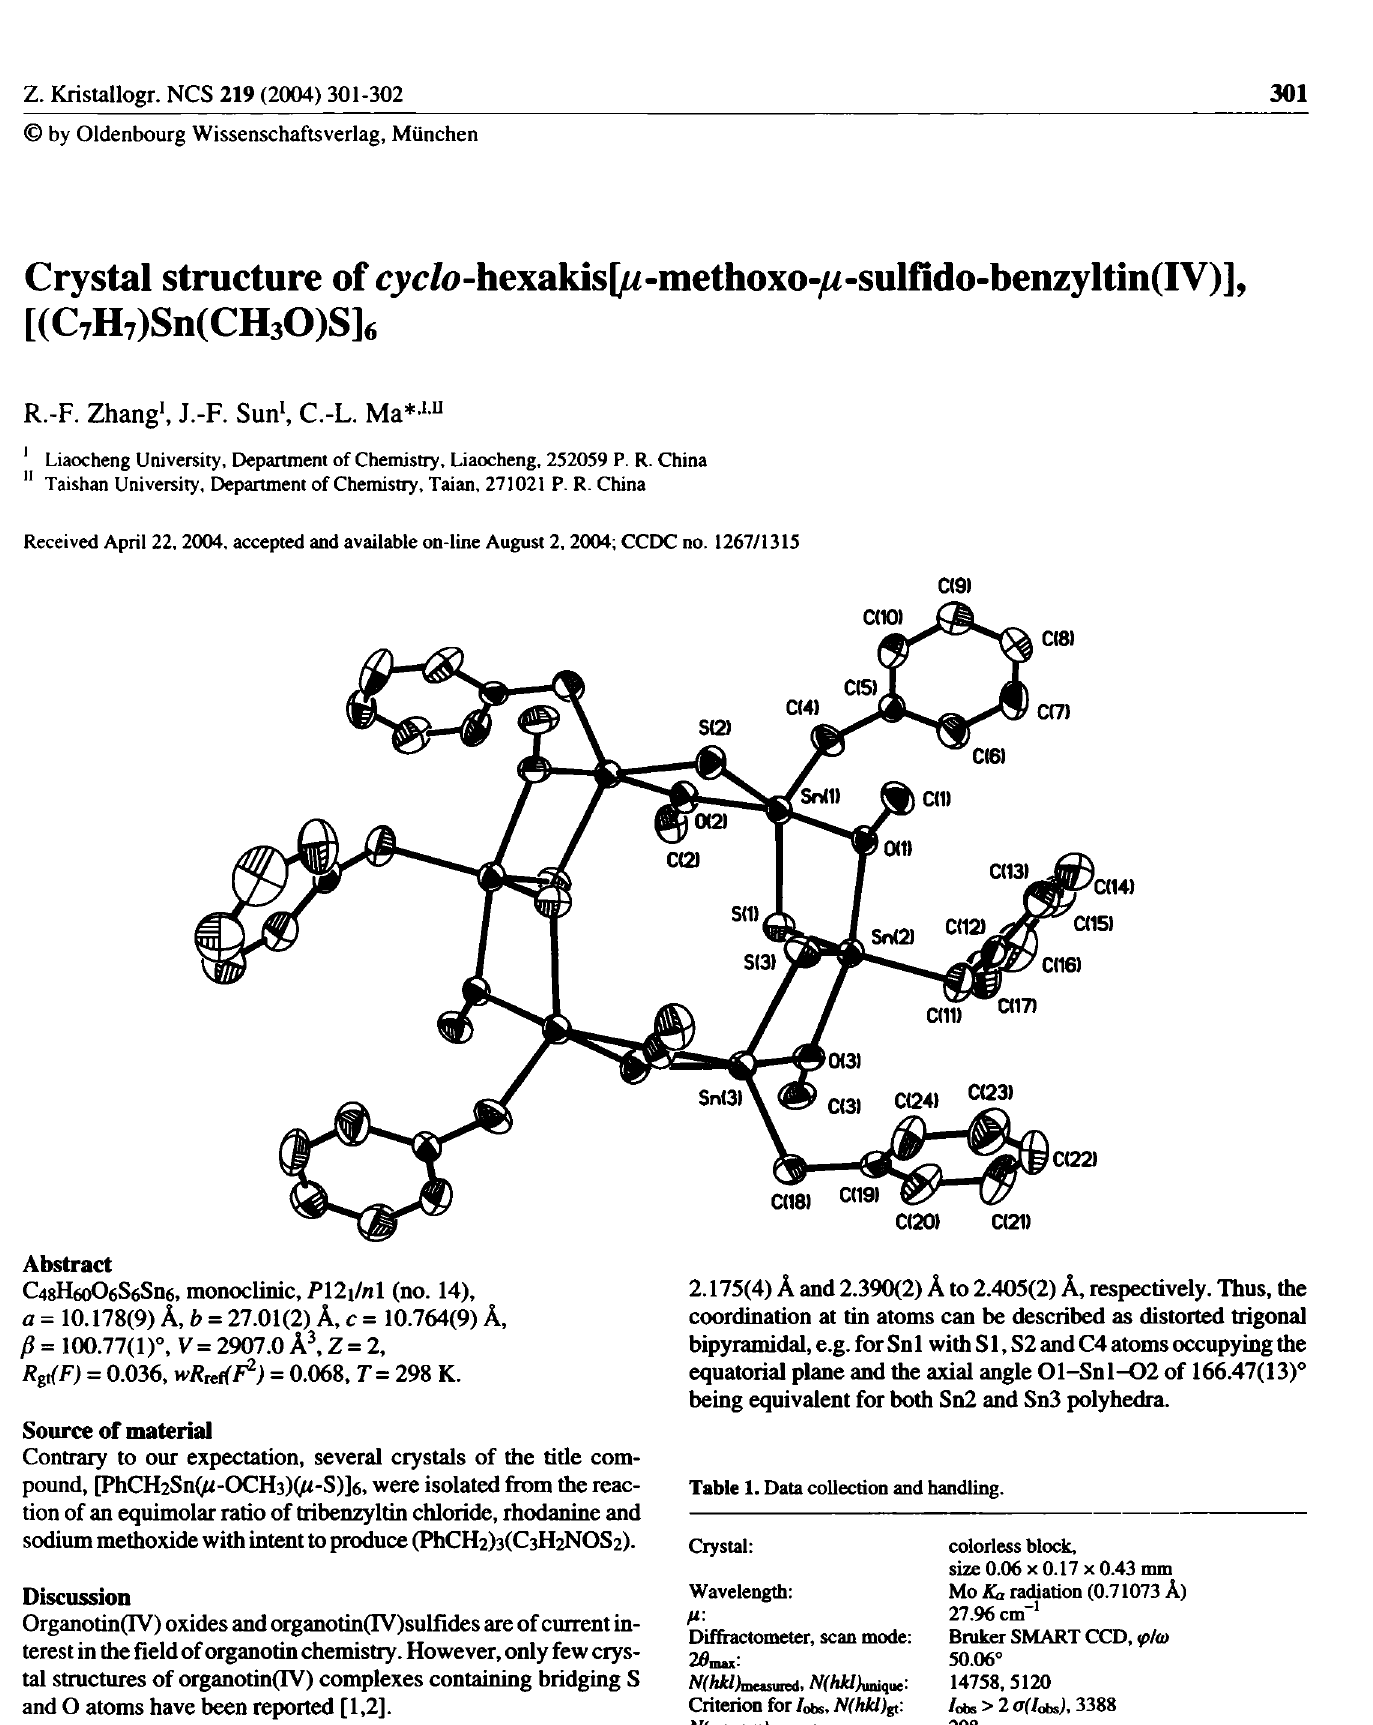
Table 1. Data collection and handling.